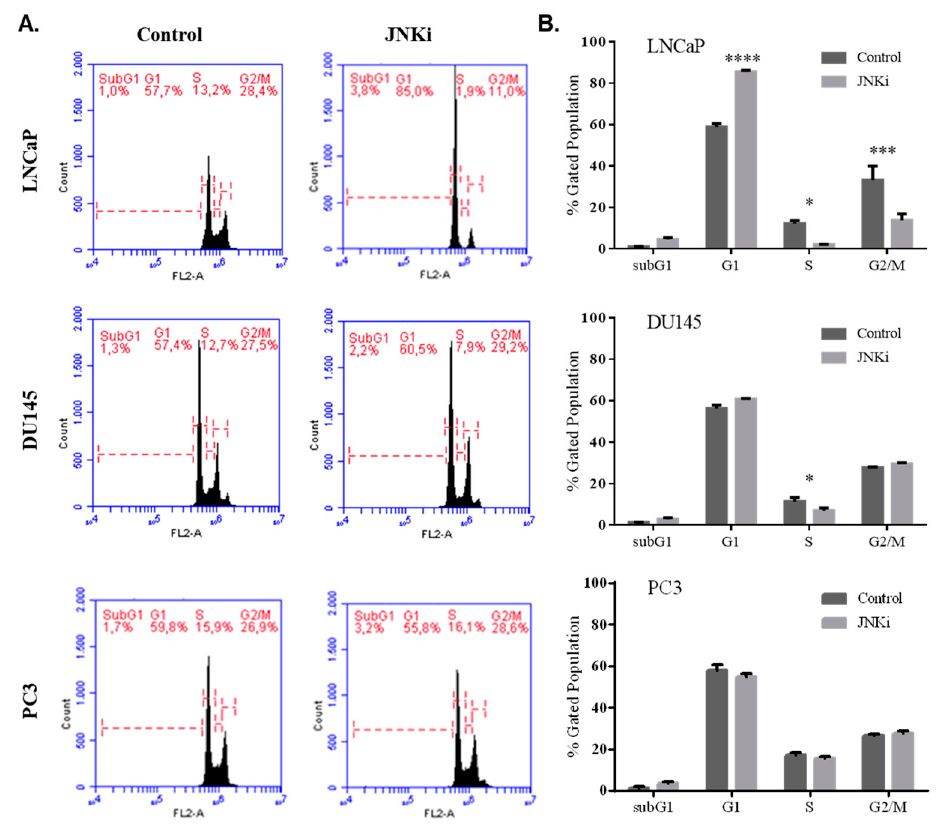
Figure 2. JNKi-induced cell cycle arrest was detected at the G1 phase in LNCaP, but not in DU145 and PC-3 cells. ( A ) DNA content was analysed by flow cytometry (right figures). ( B ) The percentage of cells in the G1, S, and G2 / M phases of the cell cycle are shown in the graphics for each cell. The representative results are shown (* p = 0.03, ** p = 0.021, *** p = 0.0002, **** p < 0.0001; n = 3).